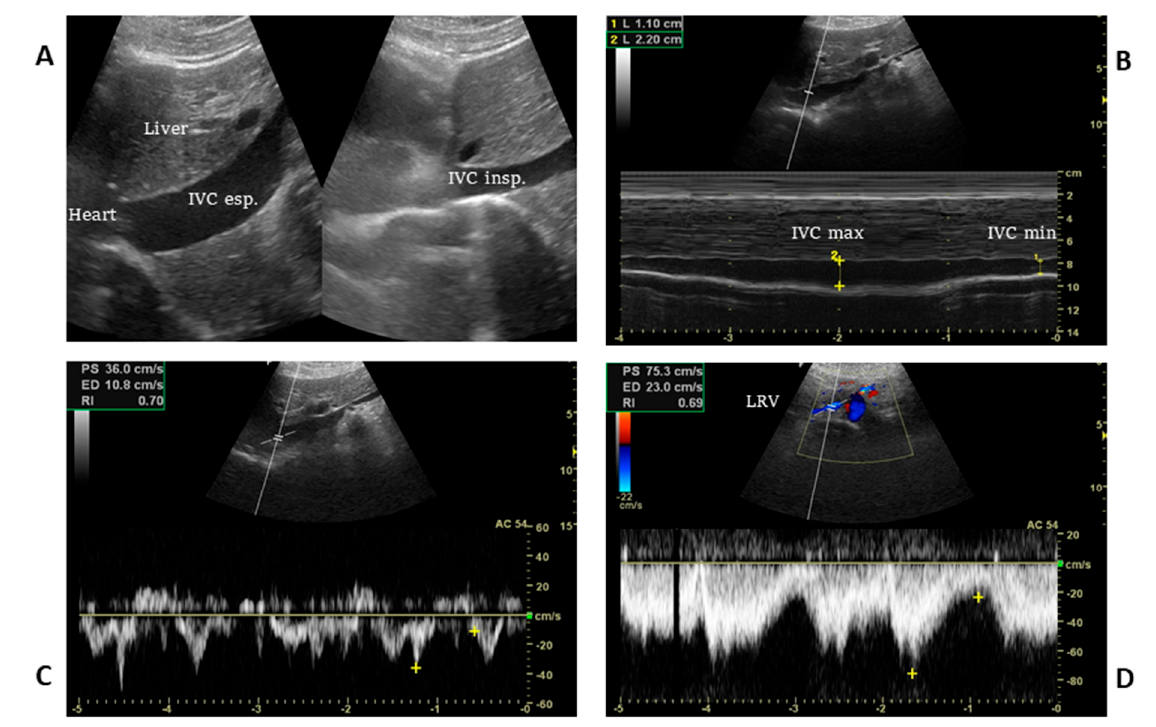
Figure 3. A longitudinal scan of the inferior vena cava including the veno–atrial junction ( A ) and the right coronal transhepatic scan along the posterior right axillary line ( B ). B-mode ( A ) is used to identify the inferior vena cava and then the Doppler M-mode ( B ) is applied with the sweep velocity set at 25 to 50 mm/s depending on the respiratory rate in order to include at least three respiratory cycles. The maximum and minimum IVC diameters are used to obtain the collapsibility index (in the example, cIVC is 50%). Pulsed wave Doppler in the IVC ( C ) and at the outlet of the left renal vein ( D ) may provide additional information to estimate CVP, as the presence of continuous flow equates to low to normal central venous pressure. (IVC: inferior vena cava, LRV: left renal vein, yellow + : peak velocity at end-expiration and end-inspira- tion).